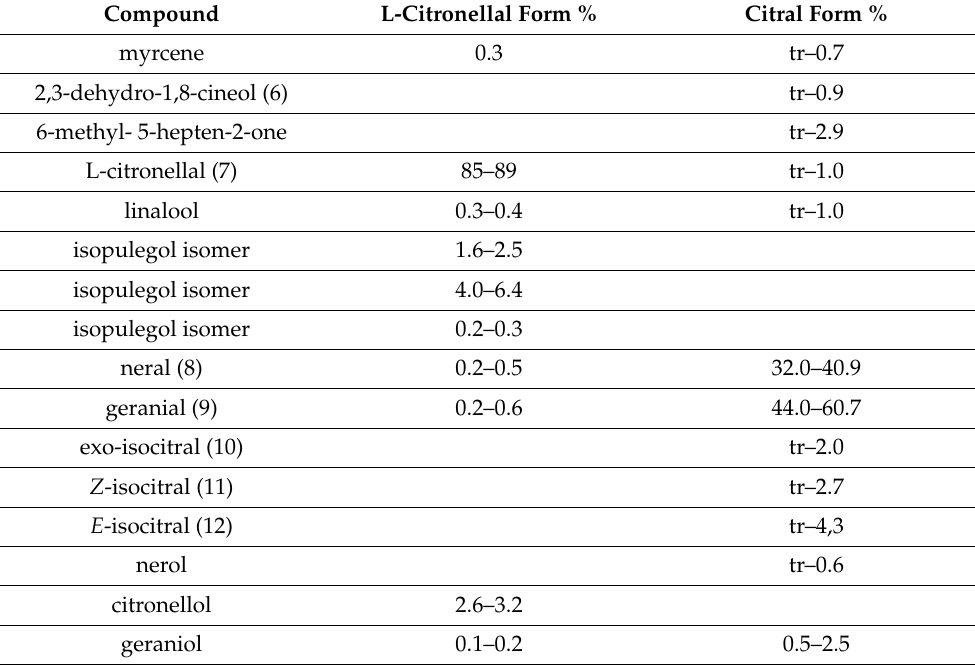
Table 5. Composition of the leaf oils of the two chemotypes of Backhousia citriodora .